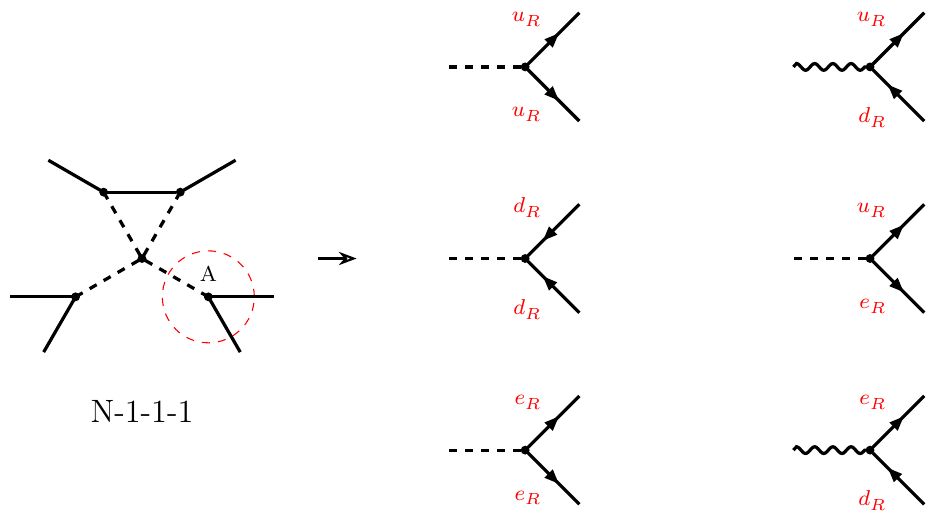
Figure 3 . The possible ways of attaching the fields of the operator N4 to the external legs of the vertex A in diagram N-1-1-1, where the dashed lines and wavy lines on the right side denote scalar and vector fields respectively. Notice that Lorentz invariance fixes the mediator to be scalar or vector because the external legs are fermions with definite